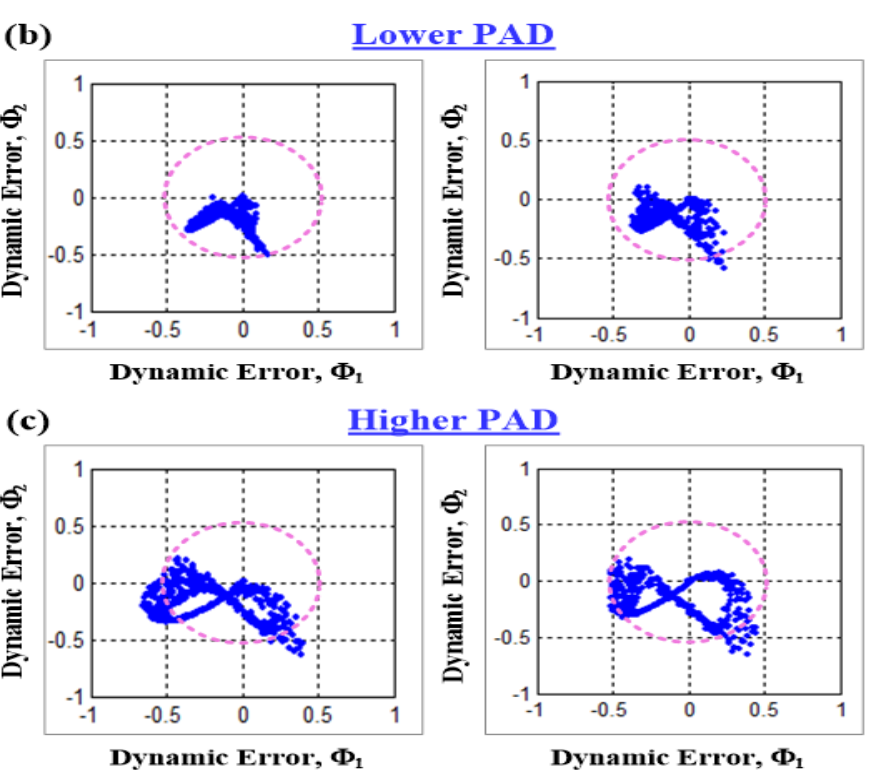
Figure 3. Dynamic error scatter diagrams for different risk levels: ( a ) normal condition (Nor), ( b ) lower PAD (LPAD), and ( c ) higher PAD (HPAD).